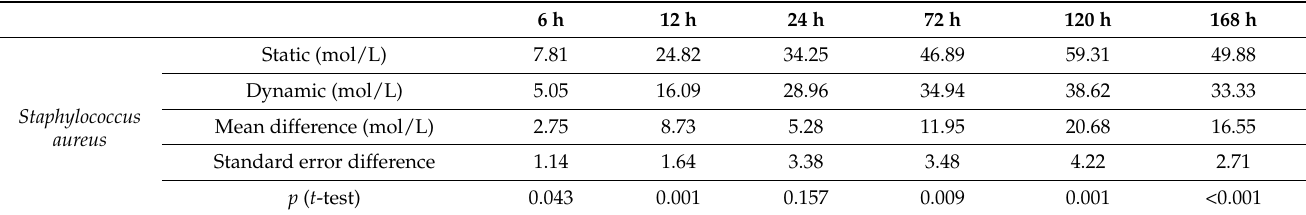
Table 1. The static (3D-printed plates) and dynamic (3D-printed microfluidic devices) measurements of the bacterial biofilm produced by the wild strains (5 of each species) as well as the statistical comparison between the two